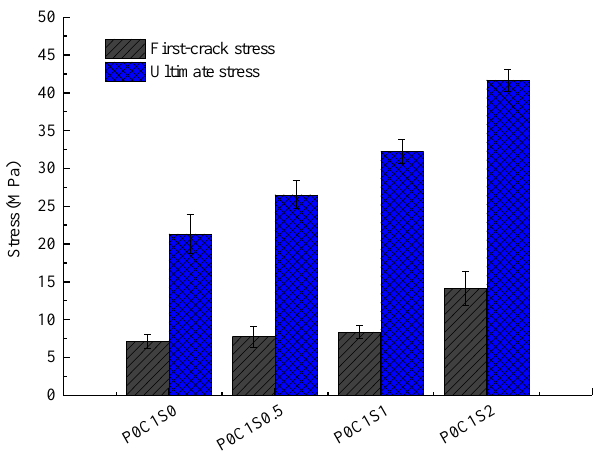
Figure 15. First-crack and ultimate stresses of the TRC specimens with different volume contents of steel fibres.